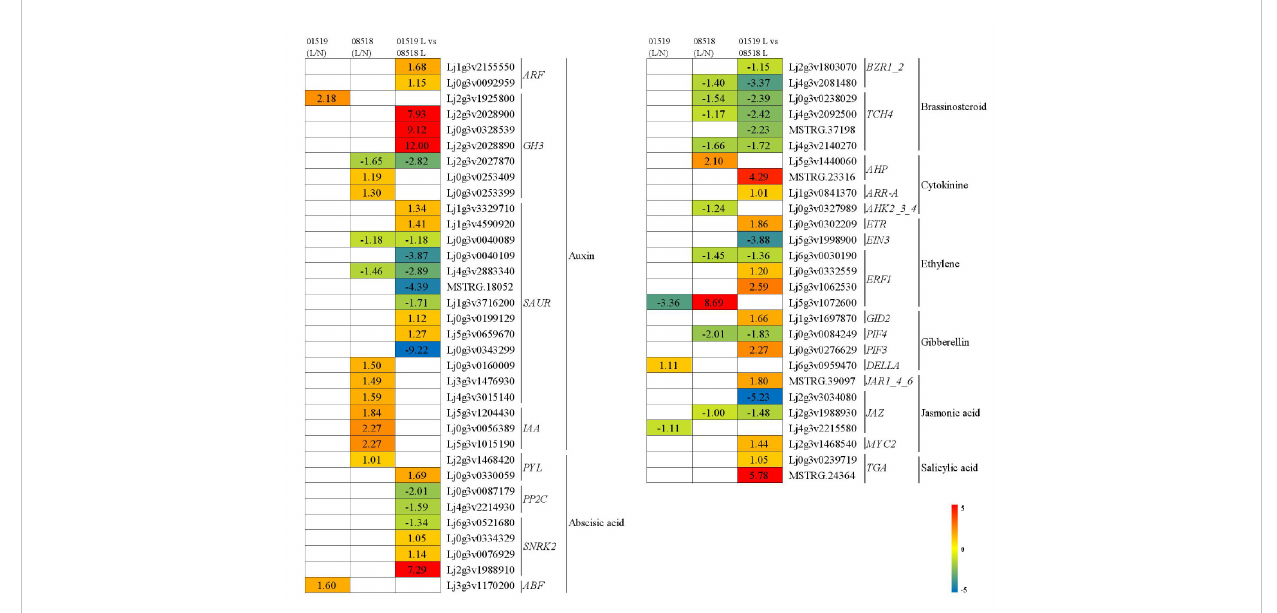
FIGURE 5 Plant hormone signal transduction-related genes identi fi ed in the RNA-seq analysis that showed changes in expression during low-P stress. Log 2 (fold-changes) of the comparisons are shown by the numbers in the gray rectangles. The comparisons show that each of the genes in the picture is signi fi cantly differentially expressed.